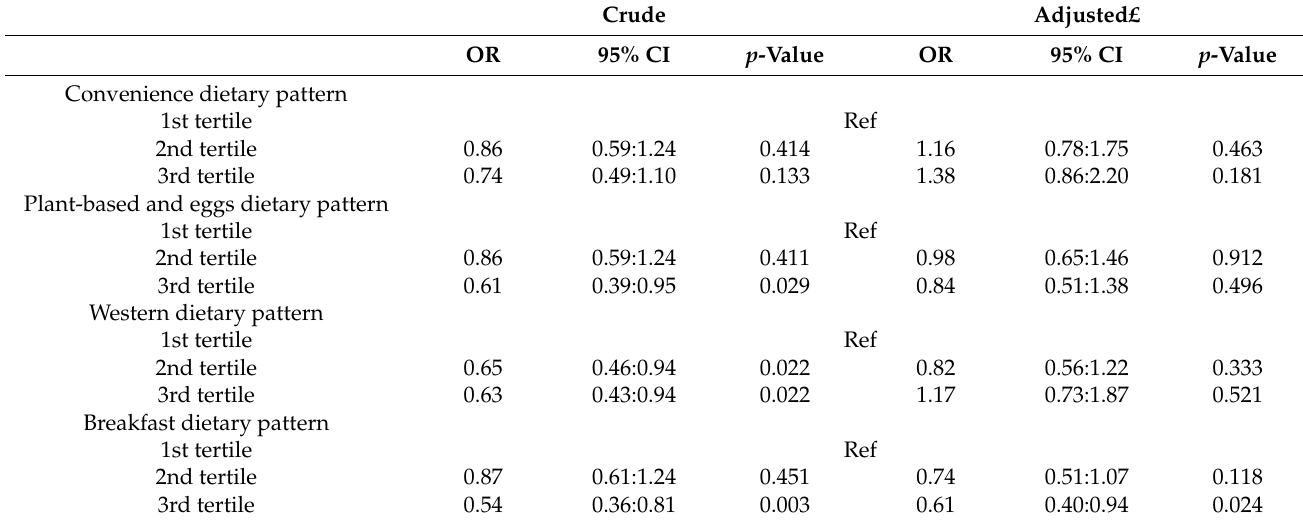
Table 4. Association between the tertiles of dietary patterns and overweight/obesity in the girls. HELENA study. Crude Adjusted£ OR 95% CI p -Value OR 95% CI p -Value Convenience dietary pattern